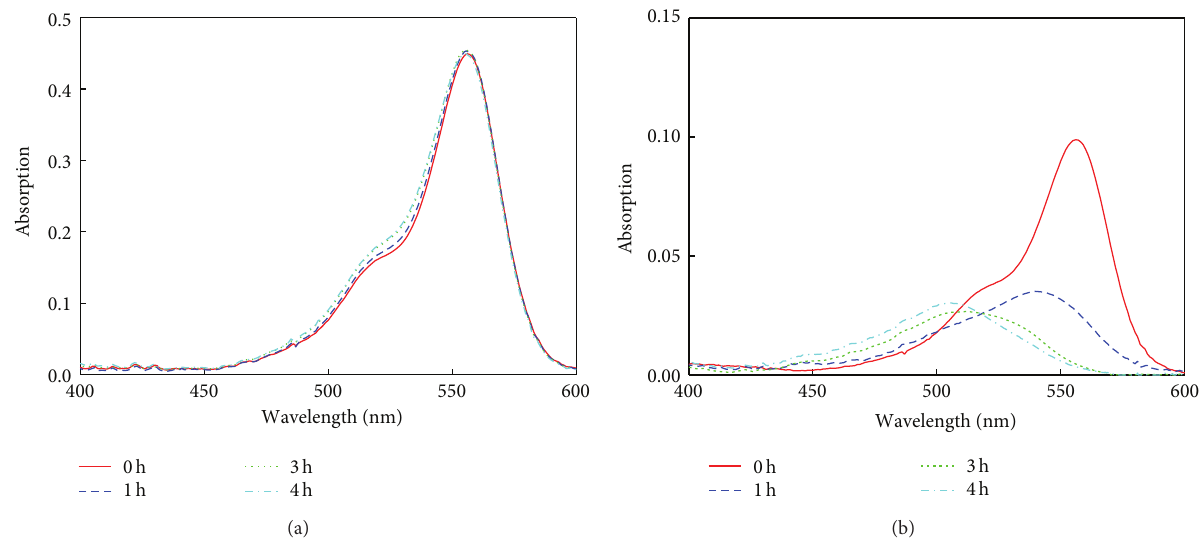
Figure 4: Absorption spectral change of RhB in the suspension of (a) Pt/TiO 2 and (b) Pt/TiO 2 /Nf as a function of irradiation time. Experimental conditions: [catalyst] = 0.5 g L −1 , [RhB] = 20 𝜇 M, [EDTA] = 4 mM, pH 𝑖 = 2.3 , and 𝜆 > 420 nm. Samples were diluted by 3 times for the